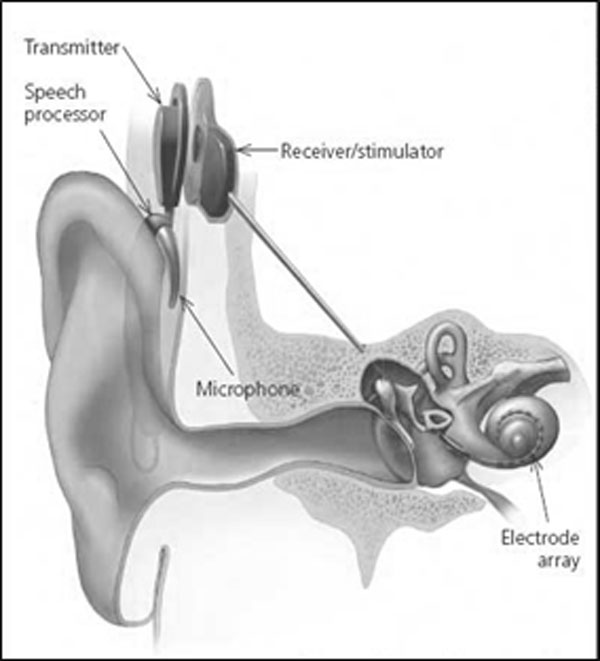
External and internal parts of a cochlear implant